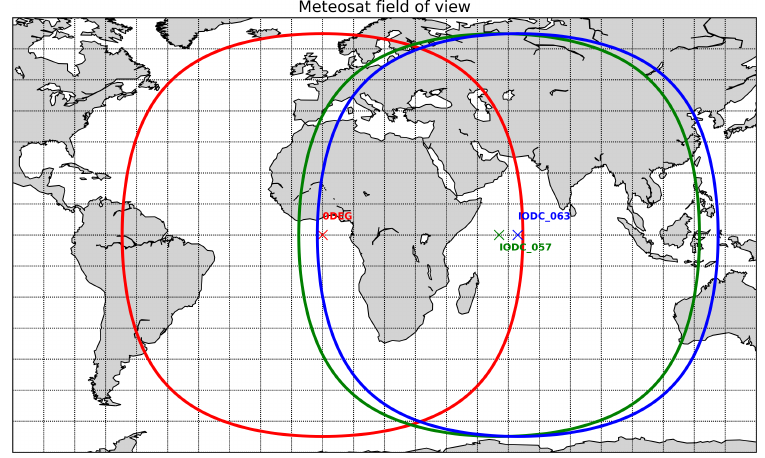
Figure 2. Meteosat field of view: Prime mission 0-degree (red), IODC 57-degrees (green) and IODC 63-degrees